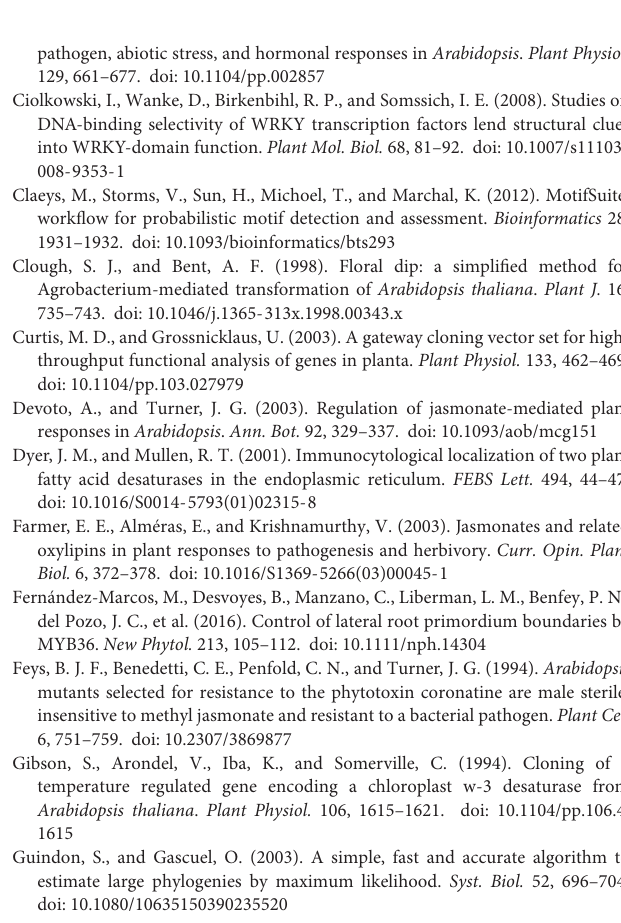
Supplementary Figure 1 | GUS histochemical activity in seeds from Arabidopsis transgenic lines expressing the 1,682 bp AtFAD 7 promoter:GUS fusión (A) , the 2,958 bp AtFAD8 promoter:GUS fusión (B) and the empty vector (C) . A detail photograph of the extremes of the pod in A is also shown. Bars represent 500 µ m size. Supplementary Figure 2 | (A) Effect of 100 µ M MeJA on the GUS histochemical staining in 2-week old plants from transgenic lines carrying the AtFAD8 2,958 bp promoter fragment and the 1,912 bp, 643 bp and 290 bp deleted promoter fragments, respectively. Upper panel shows control untreated plants. Lower panel shows plants treated with 100 µ M MeJA for 2 h. Results were obtained after 3 h of GUS staining. Images are representative of at least three independent transgenic lines. Scale bars represent: 1,000 µ m in plantlets. (B) Effect of 100 µ M MeJA on the GUS histochemical staining in cotyledonal and true leaves from 2-week old plants carrying the control AtFAD8 2,958 bp promoter fragment (upper panel) and transgenic lines in which the two putative distal MYB target sequences were modified by site-directed mutagenesis (lower panel). Results were obtained after 3 h of GUS staining. MYB 8.1 8.2 represents the lines carrying the site-directed mutation on the MYB target sequences. Images are representative of at least three independent transgenic lines. Scale bars represent: 500 µ m in leaves. Supplementary Table 1 | List and names of PCR primers used in this